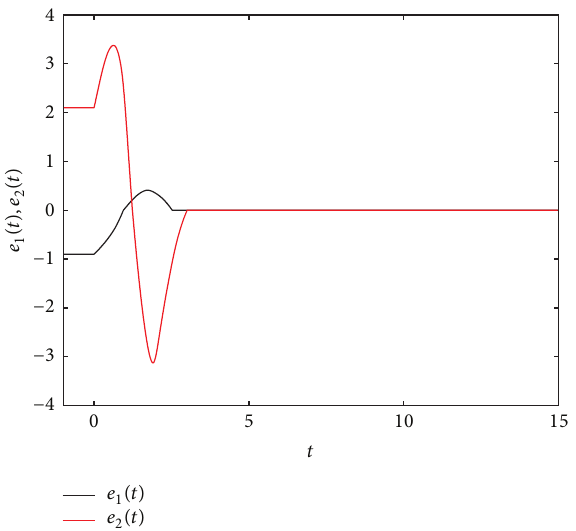
Figure 7: Trajectories of control parameters 𝑙 1 (𝑡) and 𝑙 2 (𝑡) .